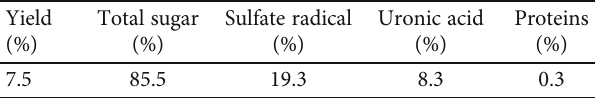
Table 1: Yield and chemical components of